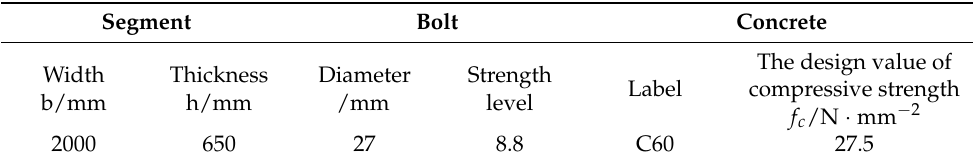
Figure 15. Comparison of M– ϕ ( a ) and K θ –M ( b ) curves between the theoretical calculation and numerical simulation ( N = 10,000 kN, positive bending moment). Table 2. Mechanical parameters of the segment